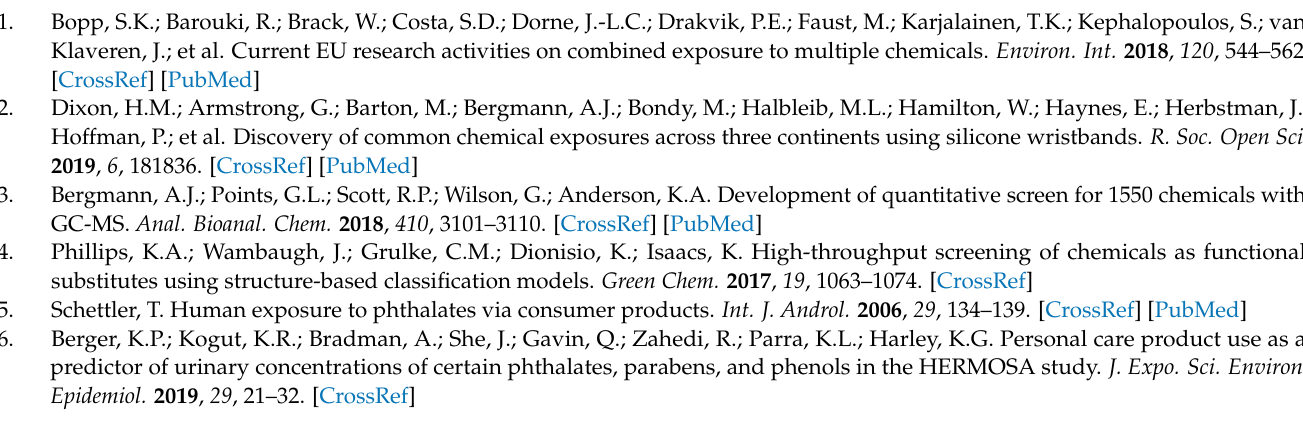
Table S4: Lowest effect levels for each chemical across NHBE and zebrafish screening; Table S5. Exposure concentrations of BMC mix components in each model system; Table S6: Summarized zebrafish embryonic photomotor response movement data; Table S7: Summarized zebrafish larval photomotor response movement